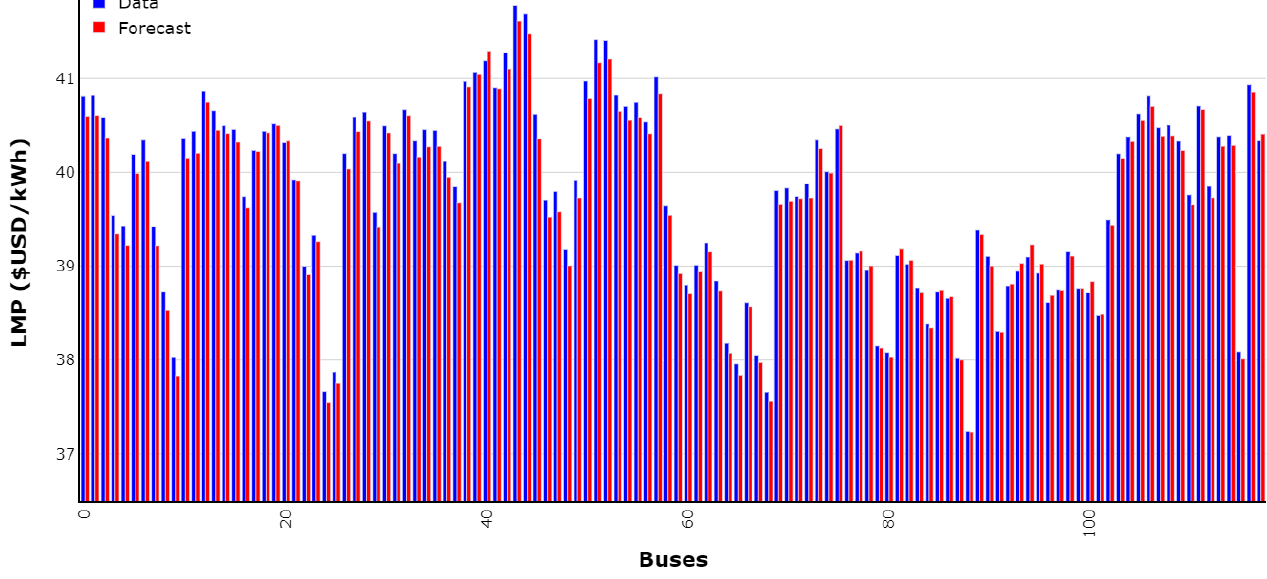
Figure 7. LMP Forecasting of all buses in a single